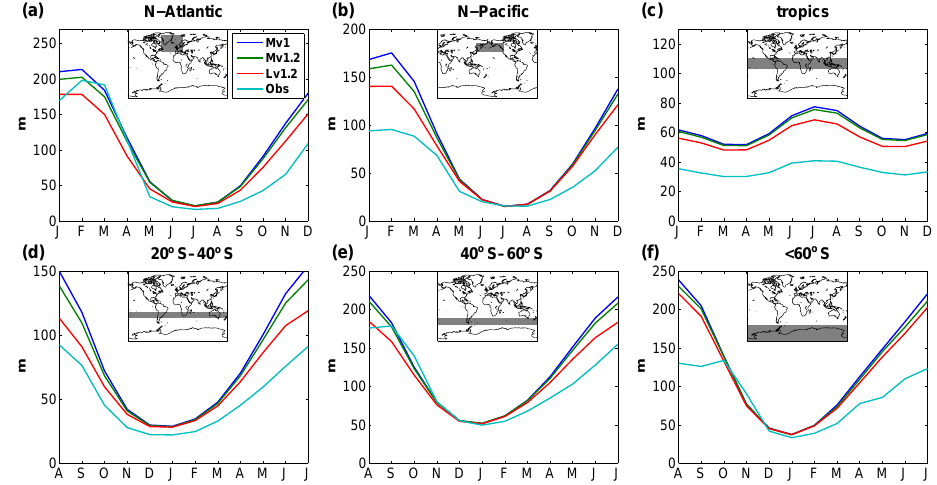
Figure 4. Mean seasonal cycle of mixed layer depth over the years 1961–2008 for the (a) North Atlantic, (b) North Pacific, (c) tropics (20 ◦ S to 20 ◦ N), (d) southern subtropics (20 to 40 ◦ S), (e) latitudes between 40 and 60 ◦ S, and the (f) Southern Ocean south of 60 ◦ S. Shown are results for model configurations Mv1 (dark blue), Mv1.2 (green), and Lv1.2 (red). The light blue line is the observation-based climatology of de Boyer Montégut et al. (2004), which uses a density threshold criterion of 0.03 kgm − 3 to define